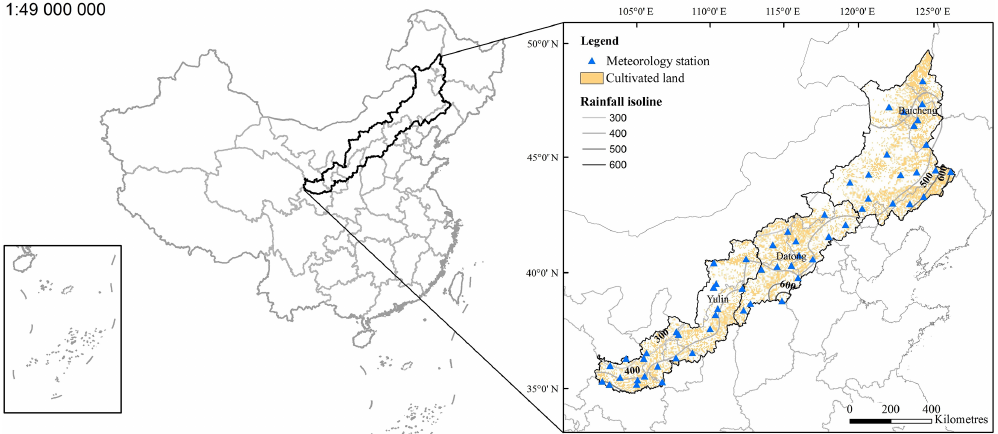
Figure 1. Location and the land-use map of the farming–pastoral ecotone in Northern China. Table 1. Meteorological, soil and relative agricultural